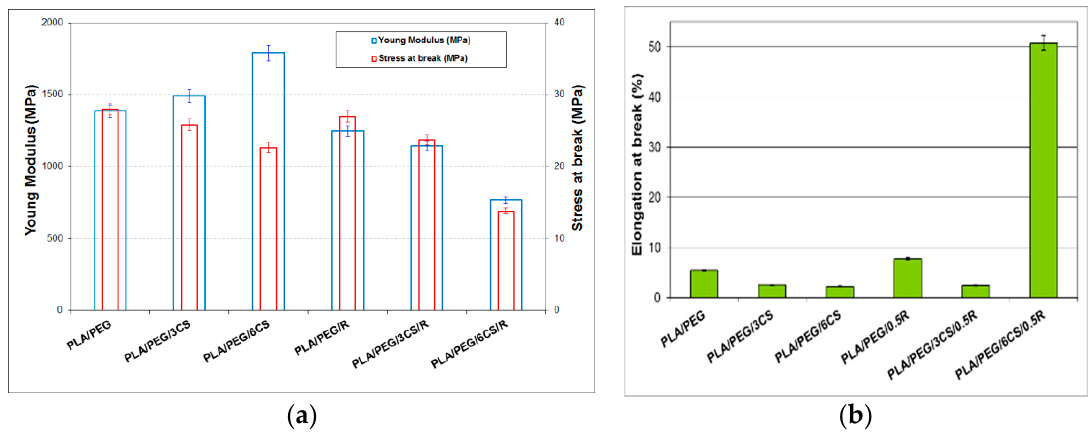
Figure 4. Tensile properties of the PEG-plasticized PLA / CS / R biocomposites: ( a ) Young’s modulus and tensile strength; ( b ) elongation at break.